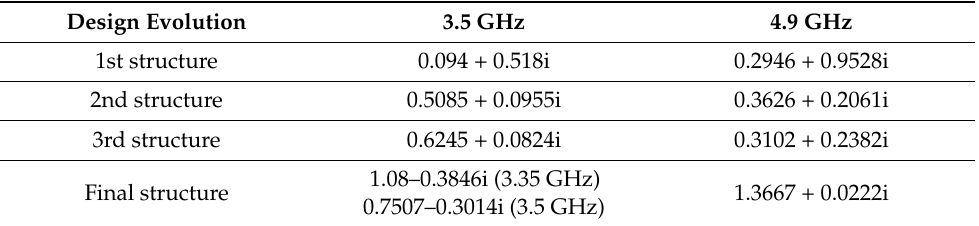
Table 1. The simulated normalized impedance at two resonant frequencies of each design stage. Design